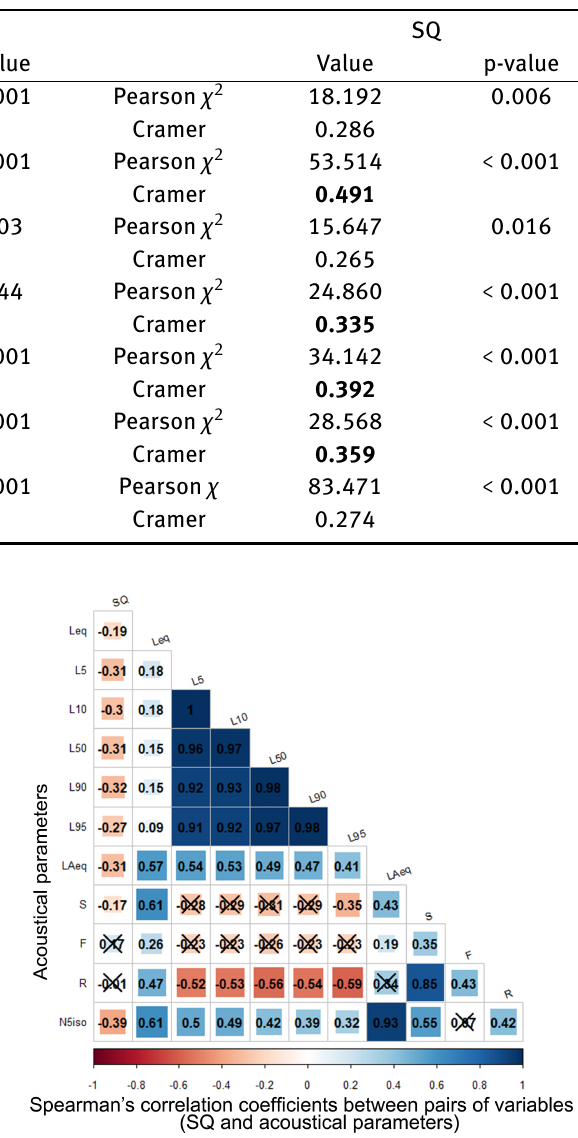
Figure 5: Spearman’s correlogram between soundscape quality (SQ) and acoustical parameters. Cells with “X” report correlation coeflcients not significant at 95% confidence